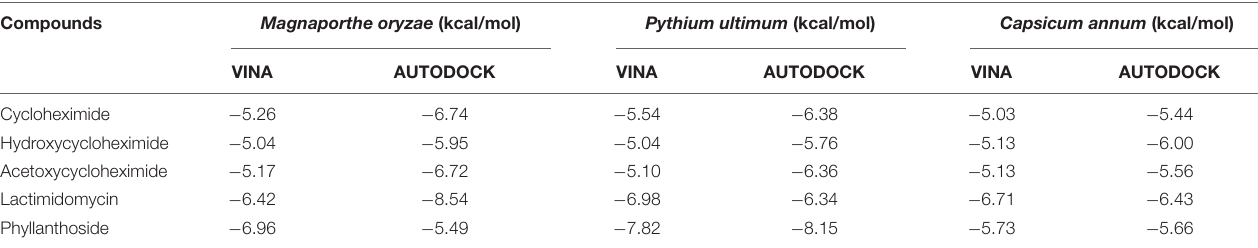
TABLE 1 | Molecular docking binding affinities of cycloheximide, hydroxycycloheximide, and acetoxycycloheximide, lactimidomycin, and phyllanthoside with the ribosomal proteins of Magnaporthe oryzae, Pythium ultimum, and Capsicum annum using AUTODOCK and VINA, respectively. Compounds